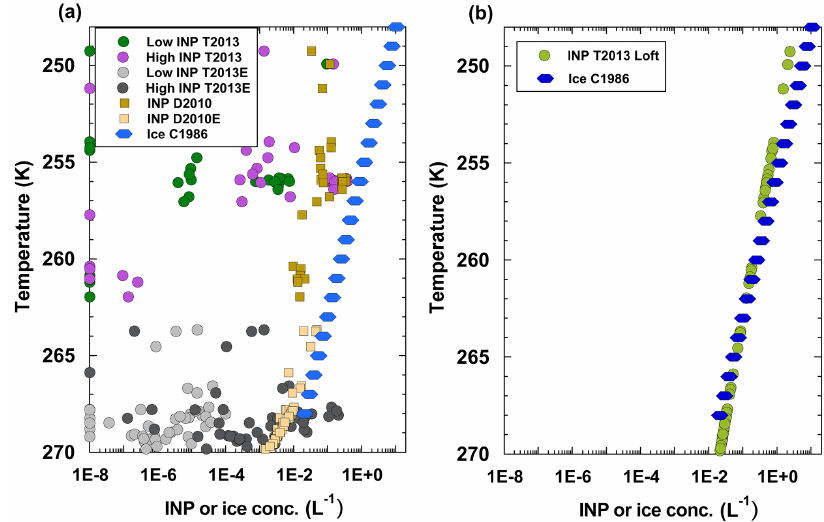
Figure 8. (a) Predicted INP concentration based on Tobo et al. (2013) (T2013) Eq. (3) and actual fluorescent biological particle concentrations (0.8–12µm) measured from the aircraft. Dark green and magenta circles are for low and high FBAP values, respectively, based on different definitions of which fluorescent particles are biological, as discussed in the text. Light and dark grey circles (T2013E) are extrapolated to warmer temperatures than the data used in T2013. Zeros are plotted as 1 × 10 − 8 on the log scale. Brown squares are based on the global parameterization D2010 of DeMott et al. (2010) with WIBS-4A particle concentration between 0.8 and 12µm substituted for particles >0.5µm. Lighter brown squares (D2010E) are extrapolations to warmer temperatures. Dark blue hexagons represent typical concentrations of primary ice at varying temperatures in clouds as measured and parameterized by Cooper (1986) (C1986). (b) Light green circles are a hypothetical prediction of INPs based on an FBAP concentration of 69L − 1 at 281K, assuming boundary-layer FBAPs were lifted to colder temperatures without losses in concentration. Dark blue hexagons are ice concentrations as in panel (a) , based on C1986. Note that all data are presented here in ambient concentrations; however, as an intermediate step, FBAPs and INPs were converted to standard concentrations to use with the T2013 and D2010 parameterizations, as required for the equations developed in those papers. For adjusting air density, a best-fit relationship between temperature, T (K), and pressure, P (mb), was developed for all flights: P = 1428 − 15 . 753 × T + 0 . 046654 × T 2